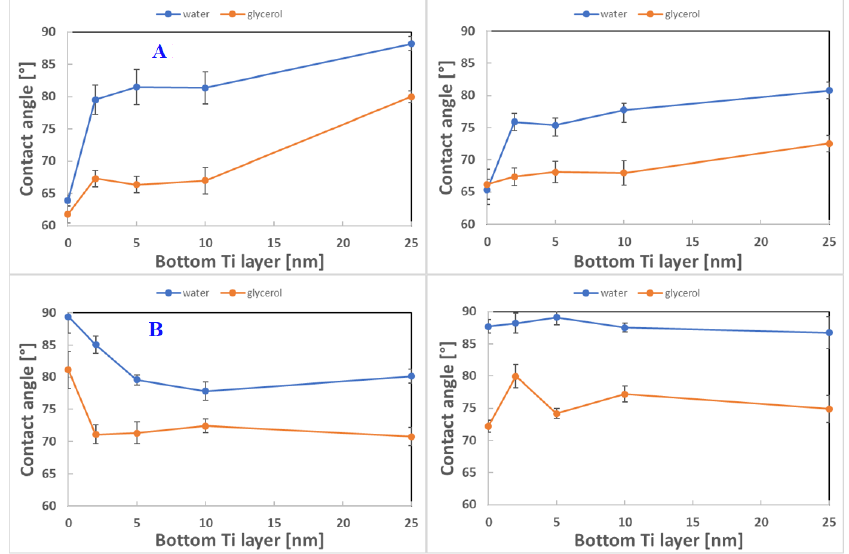
Figure 10. ( A ) The contact angle of the modified samples with the lower layer of titanium and the upper layer of gold with a total thickness of 50 nm. Unheated samples on the left, heated samples on the right. ( B ) The contact angle of modified samples with a bottom layer of gold and a top layer of titanium with a total thickness of 30 nm. Unheated samples on the left, heated samples on the right.